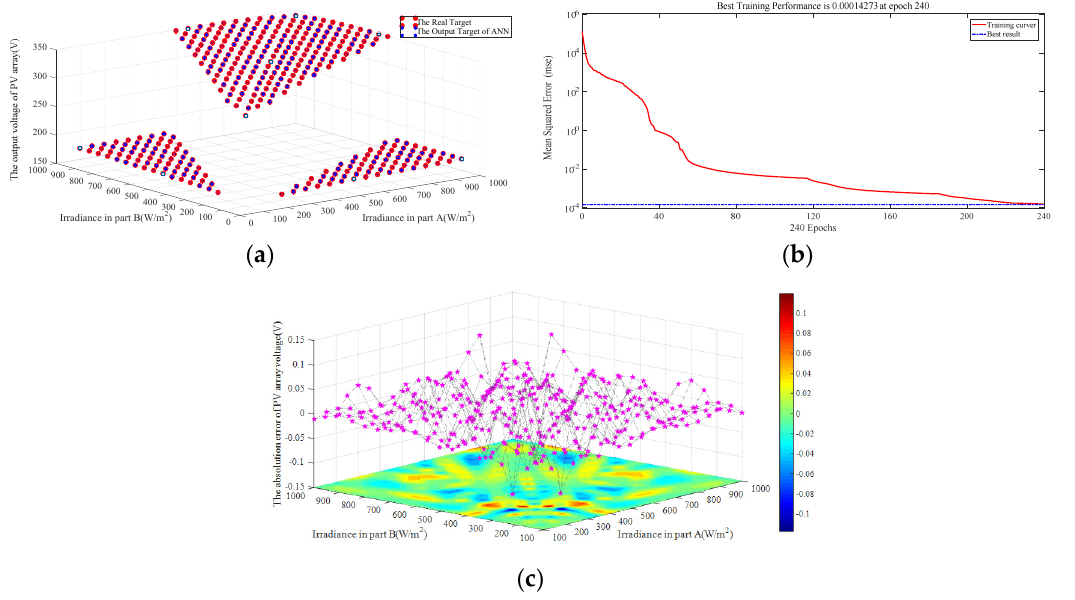
Figure 5. Testing data of ANN controller: ( a ) The output of the neural network training with the amount of target data; ( b ) the mean squared error (MSE) in converging process; ( c ) the absolute error of neural network training.